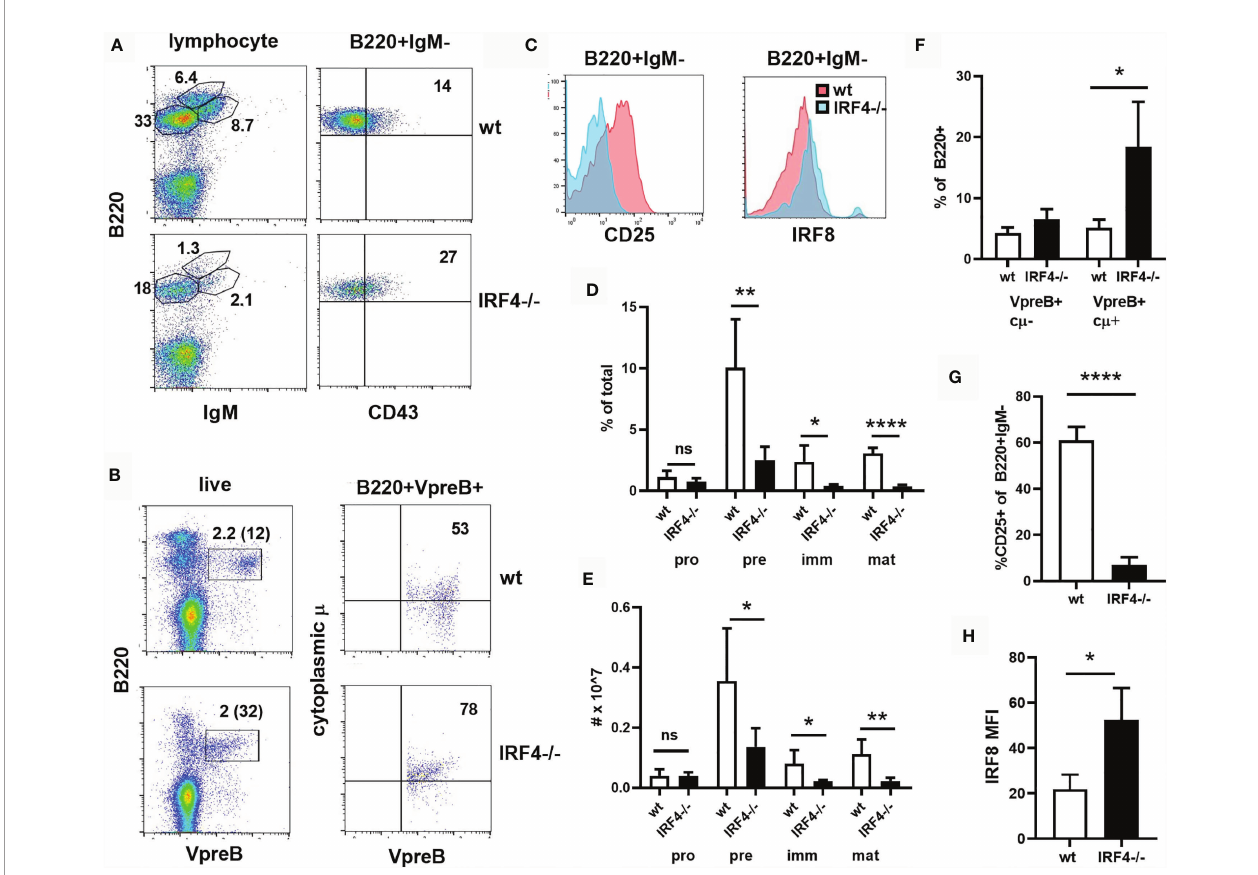
FIGURE 1 | Partial block beyond the preBCR+CD25- stage of B cell development in IRF4-de fi cient bone marrow. (A) Bone marrow was stained with antibodies against B220, IgM and CD43. The gate used is shown above the plots, and the frequency of cells in the relevant gates is indicated. (B) Bone marrow was stained extracellularly with anti-B220 and intracellularly with anti-VpreB and anti-IgM heavy chain (cytoplasmic m or c m ). The gate used is shown above the plots. The frequency of cells in the relevant gates is indicated [on the left plot as a percentage of total and of B220+ (in parentheses)]. (C) Bone marrow was stained with antibodies against B220, IgM, and CD25 or intracellular IRF8. CD25 and IRF8 histograms are shown for B220+IgM- cells. Red = wt, blue = IRF4-de fi cient. (D, E) The frequency (D) and total number (E) of pro-B (B220+IgM-CD43+), pre-B (B220+IgM-CD43-), immature B (B220 med IgM+), mature B (B220 hi ) cells in the bone marrow of wt (open bars) and IRF4-de fi cient ( fi lled bars) mice, gated as in (A) . Data represent mean +/- SD, n= 5. ns, not signi fi cant; *p < 0.05, **p < 0.01, ****p < 0.0001 by Student ’ s t-test. (F) The frequency of VpreB+c m - and VpreB+c m + cells among B220+ cells is indicated, gated as in (B) . Data represent mean +/- SD, n = 4. *p < 0.05 by Student ’ s t-test. (G) The frequency of CD25+ cells among B220+IgM- cells is shown. Data represent mean +/- SD, n = 6. ****p < 0.0001 by Student ’ s t-test. (H) IRF8 gMFI in B220+IgM- cells is shown. Data represent mean +/- SD, n = 3. *p < 0.05 by Student ’ s